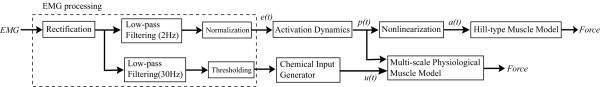
A flowchart of EMG-force estimation by the Hill-type model and multiscale physiological muscle model.